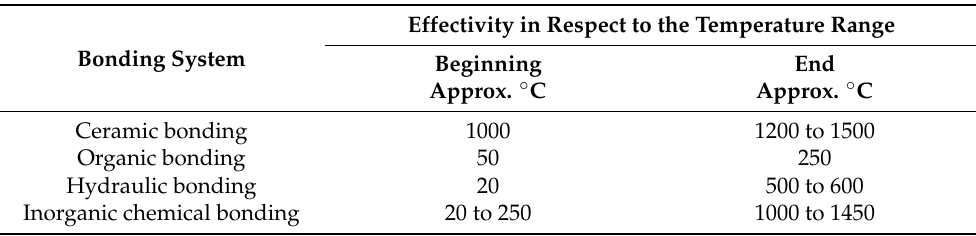
Table 1. Bonding systems and their effectivity in respect to the temperature range according to